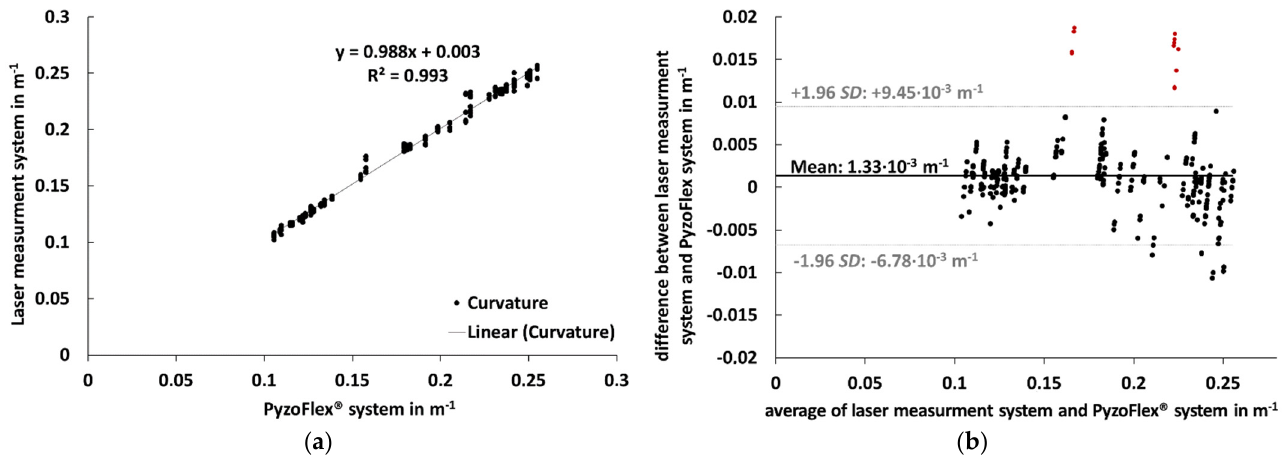
Figure 7. Left ( a ): The correlation between curvature (m − 1 ) measured by laser measurement system (criterion instrument) and PyzoFlex ® sensor system. Right ( b ): Bland–Altman plot showing the difference against the average of the laser measurement system and PyzoFlex ® sensor system with limits of agreement (LoA) (dotted lines). SD: Standard deviation.